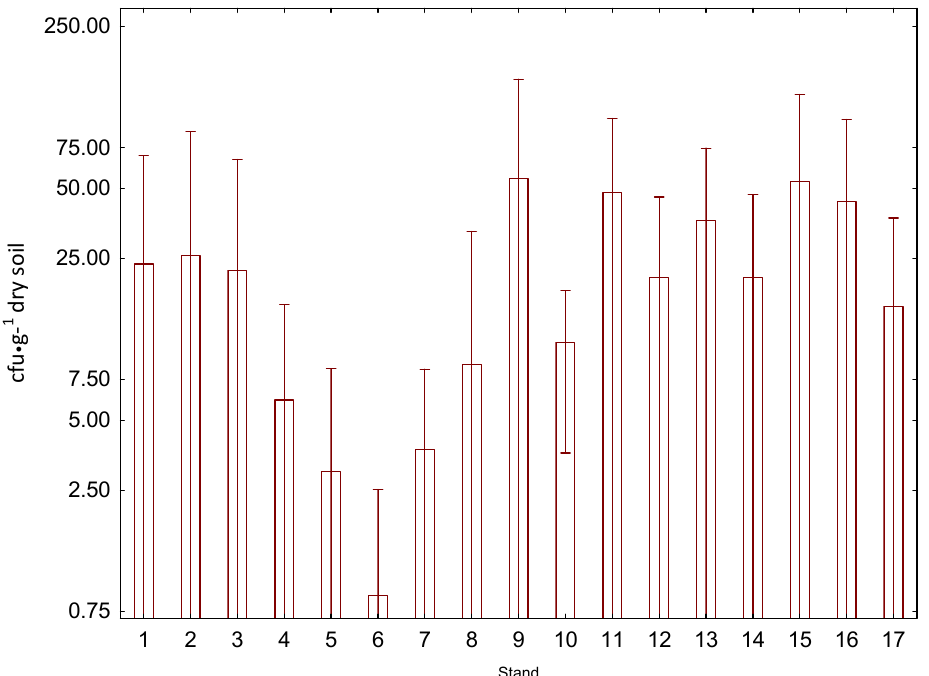
Figure 2. Average abundance (cfu g − 1 dry soil) of Salmonella sp. in the soil collected at all sampling stands located within the municipal landfill area. The data presented are means and standard deviation of two replicates.